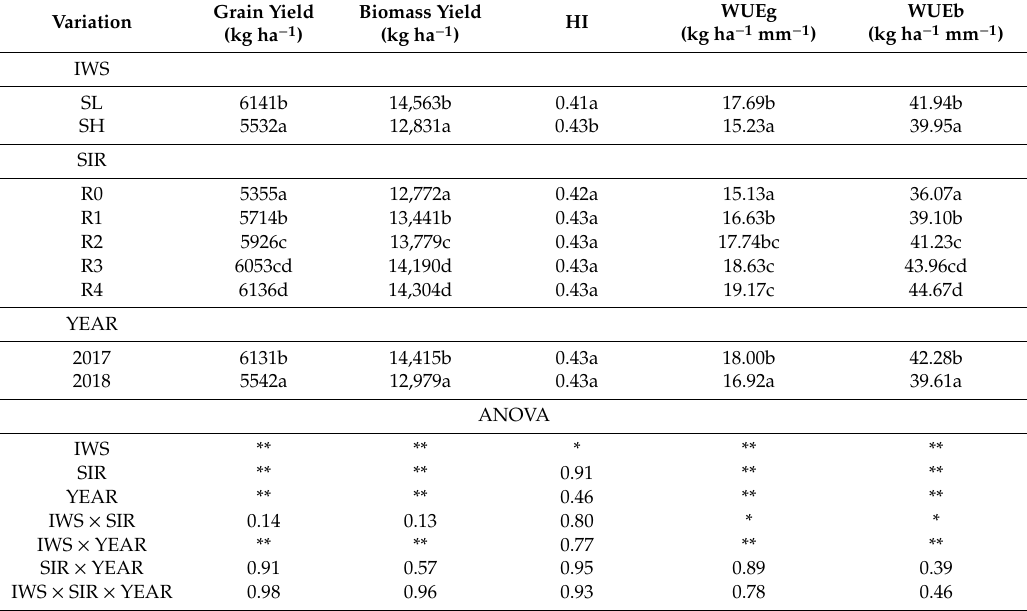
Table 6. Mean values of grain yield, biomass yield, harvest index (HI), and water use e ffi ciency at the grain (WUEg) and biomass (WUEb) level, and results of the three-way ANOVA with irrigation water salinity (IWS), straw incorporation rates (SIR), and growing season (YEAR) as factors.